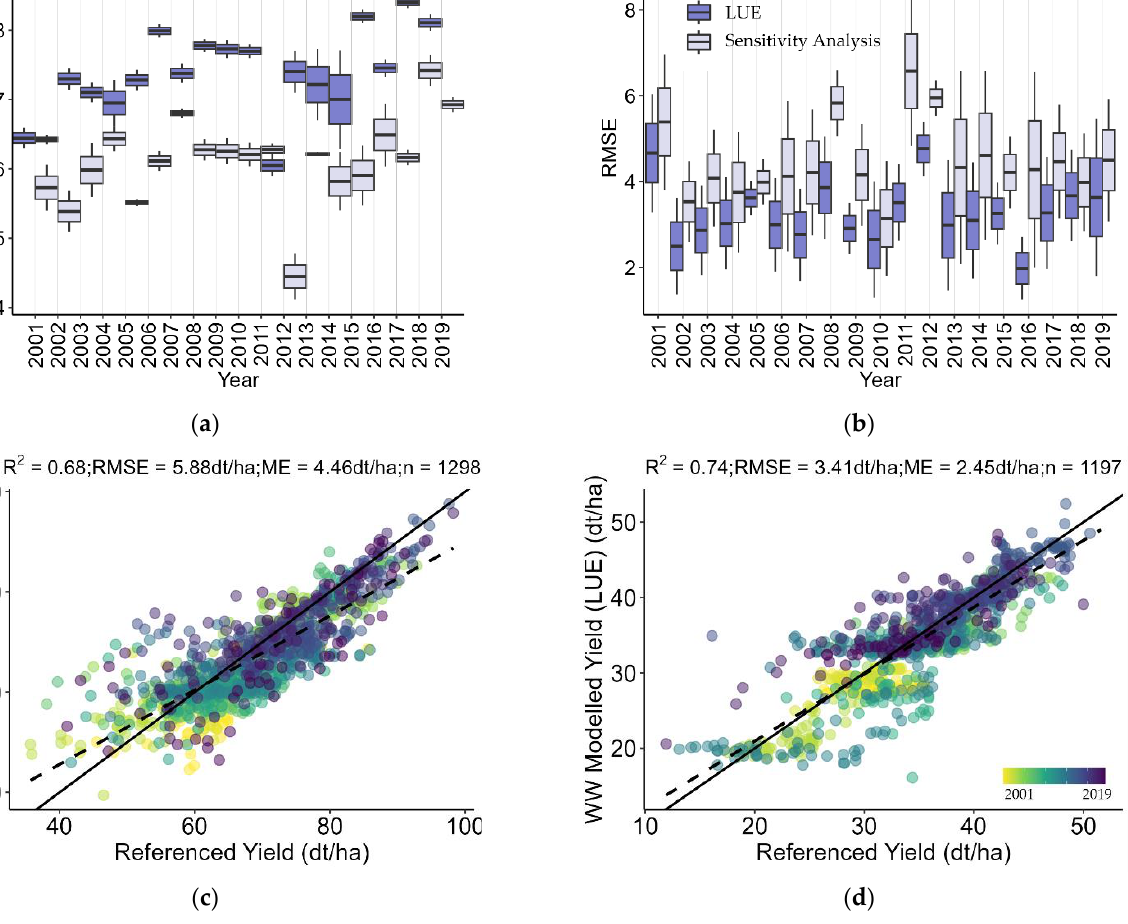
Figure 9. The bar plots show the yearly comparison of accuracies ( a ) R 2 values and ( b ) RMSE values obtained from the referenced yields (at a 95% confidence interval), with LUE-modelled yields including climate stress factors (dark blue) and LUE-modelled yields excluding the climate stress factors (sensitivity analysis) (light blue). The scatter plots compare the accuracies of the modelled and referenced yields (at a 95% confidence interval) of ( c ) WW and ( d ) OSR for 19 years together (i.e., from 2001 to 2019). The values of the statistical parameters such as R 2 , RMSE (dt/ha), ME (dt/ha), and total number of points (n) are displayed at the top of each plot. Every plot contains a solid line (1:1 line) that is used to visualise the correlation of pixels between the modelled and referenced yield values. The dashed line represents the regression line. Different colours of the points display different years.